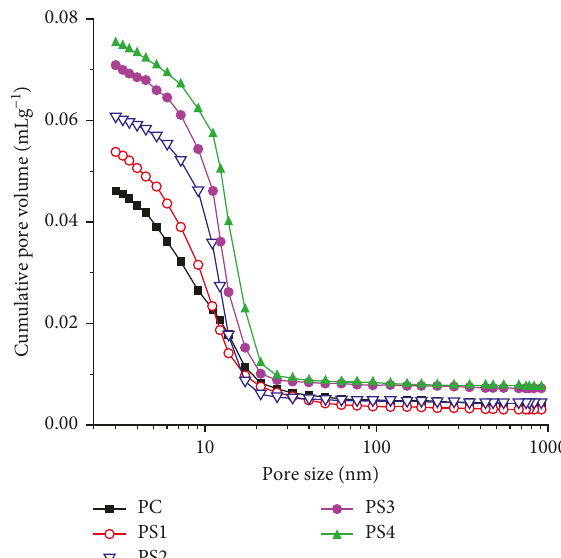
Figure 8: Pore structures of the hardened pastes at 28d.